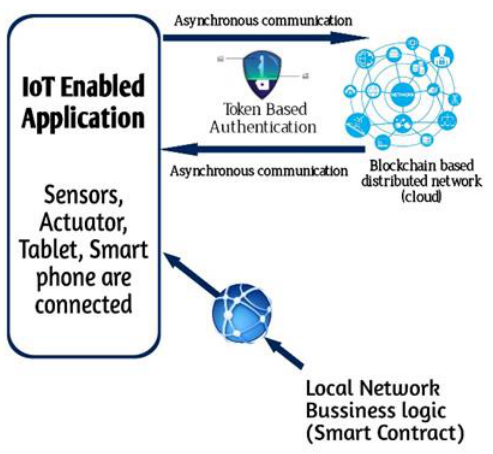
Figure 2. Iot blockchain network using smart